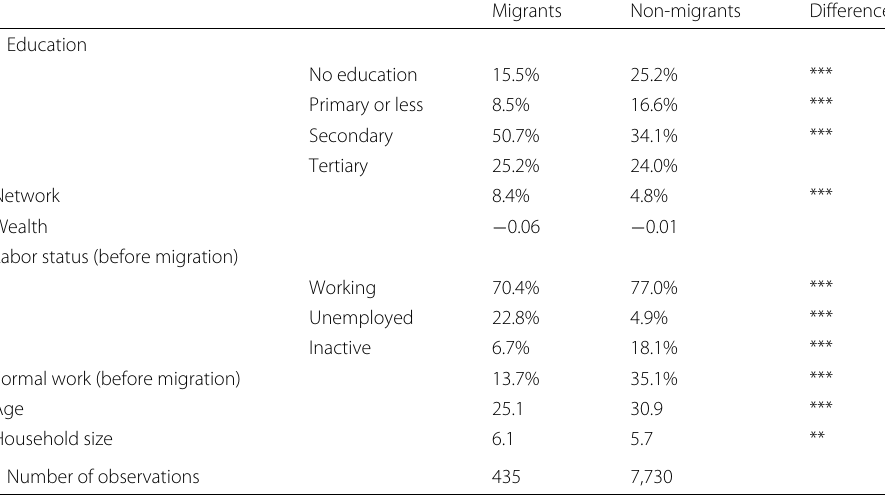
Table 2 Descriptive statistics at the individual level (sample II)